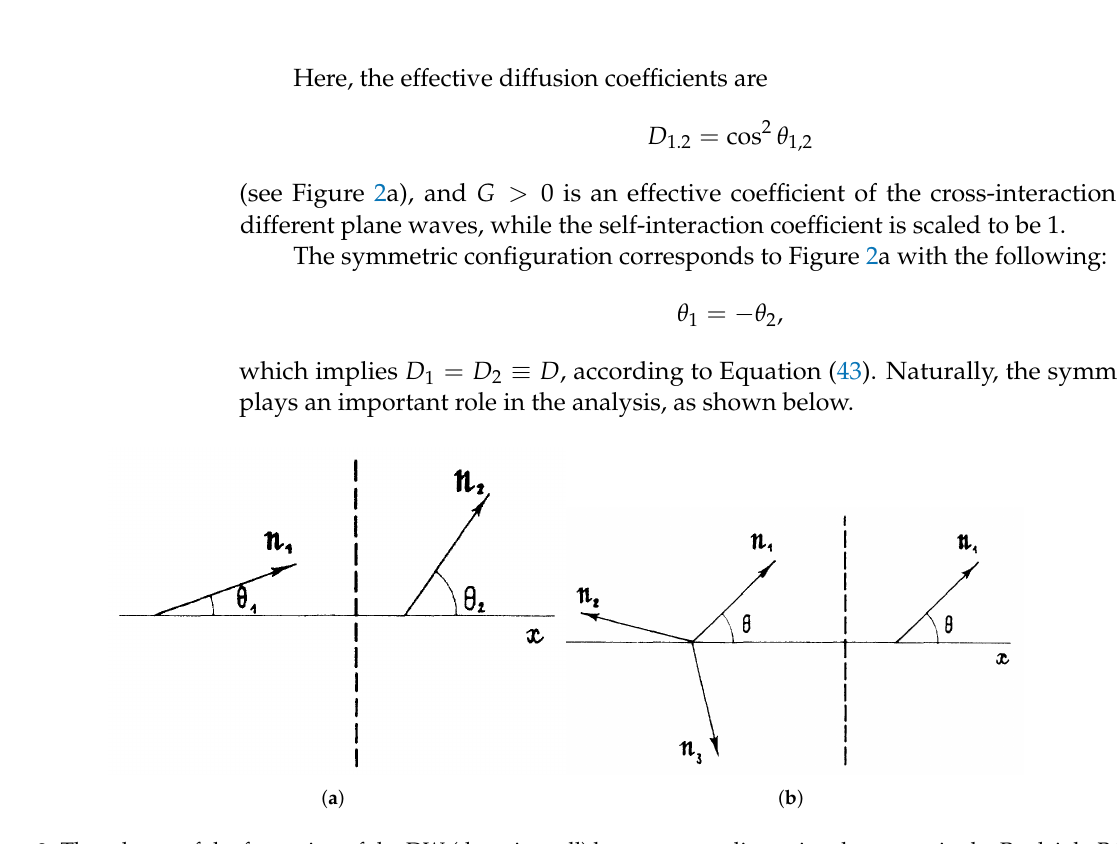
Figure 2. The scheme of the formation of the DW (domain wall) between two-dimensional patterns in the Rayleigh–Bénard convection and similar settings. ( a ) The DW between plane waves (rolls) with wave vectors oriented under angles θ 1 and θ 2 with respect to the x axis, see Equation (37). The respective amplitudes r 1,2 ( x ) satisfy Equations (41) and (42) and are subject to b.c. (40). The position of the DW is shown by the vertical dashed line. An example of the DW profile is displayed below in Figure 3a. ( b ) The same as in ( a ) for the DW between hexagons (the triple-mode pattern) and single-mode rolls. Figure is reprinted with permissions from Ref.